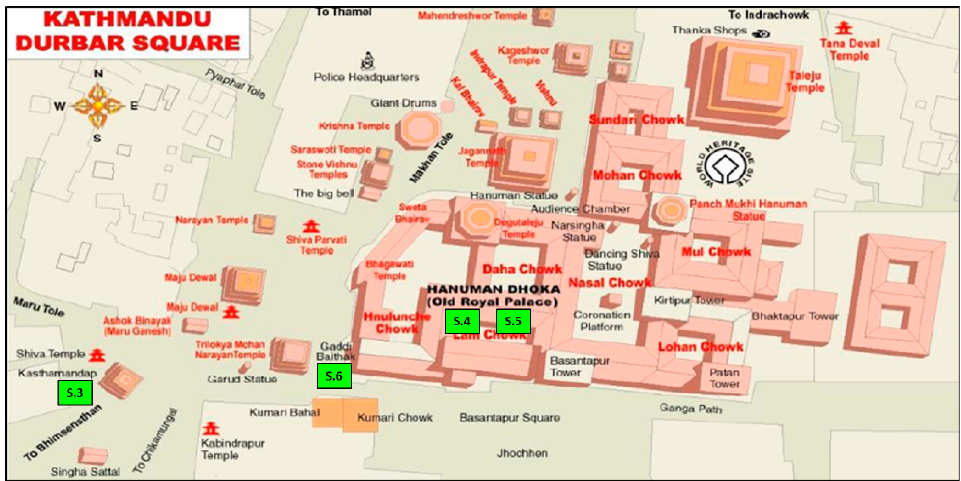
Figure A1. Layout of the Hanuman Dhoka Durbar square [2]. Location of monuments sampled indicated.